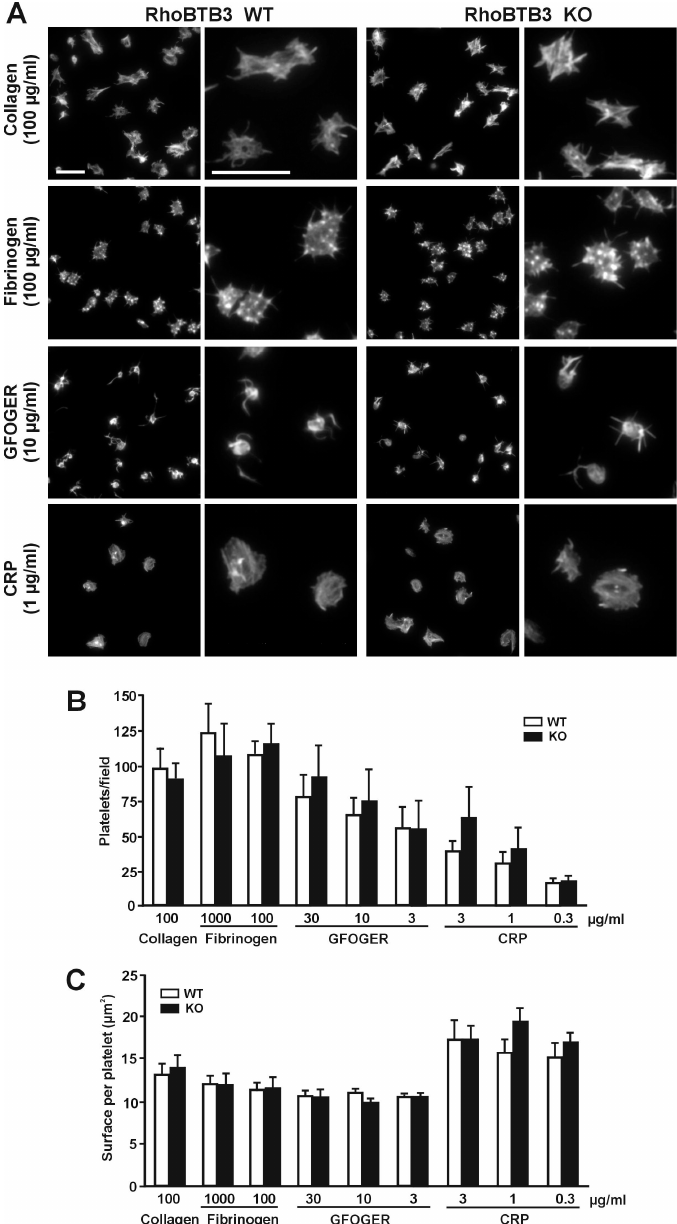
Figure 6. Unimpaired spreading of RhoBTB3 deficient platelets. ( A ) Adhesion of RhoBTB3 KO and WT platelets to glass coverslips coated with the indicated concentration of collagen, fibrinogen, GFOGER, or CRP. Adherent platelets were fixed with 4% PFA, permeabilized with 0.3% Triton X-100 and stained with TRITC-phalloidin. Platelets were visualized with a fluorescence microscope and images of random areas were acquired. For each phenotype the right column shows examples of platelets at higher magnification. Scale bars represent 5 µ m. ( B ) Number of platelets adhering to the indicated concentrations of collagen, fibrinogen, GFOGER, or CRP. 10 fields each 12,500 µ m 2 from 5–10 independent experiments were counted per condition. Data represents average ± SEM. No significant differences were found between WT and KO platelets for any condition (Mann-Whitney U-test). ( C ) Surface coverage per platelet calculated by thresholding using ImageJ. Data represent average ± SEM from 5–10 independent experiments and 250–1000 platelets per condition for each experiment. No significant differences were found between WT and KO platelets for any condition (Mann ‐ Whitney U ‐ test).